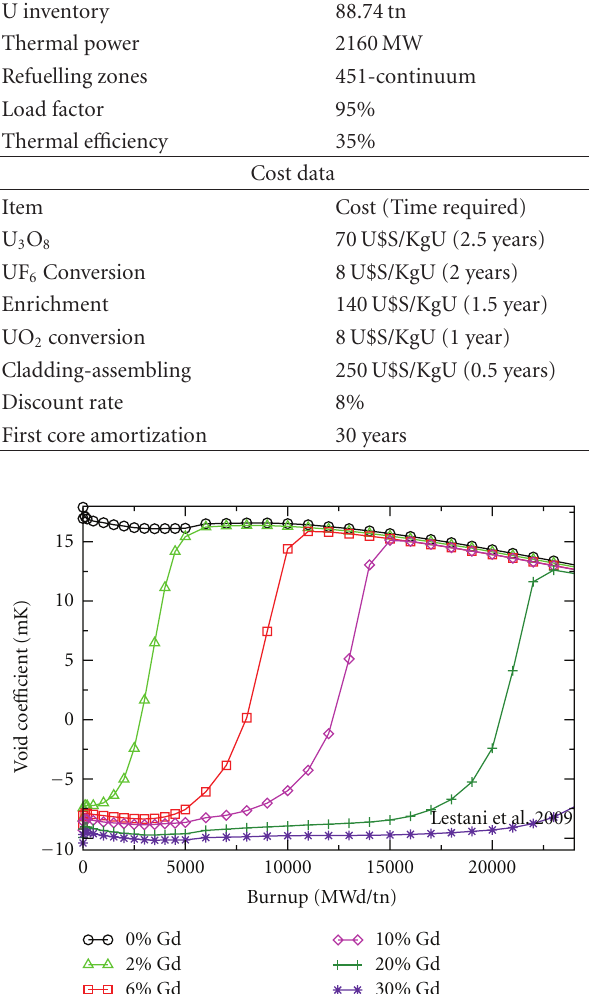
Figure 5: Evolution of coe ffi cient with burnup for di ff erent